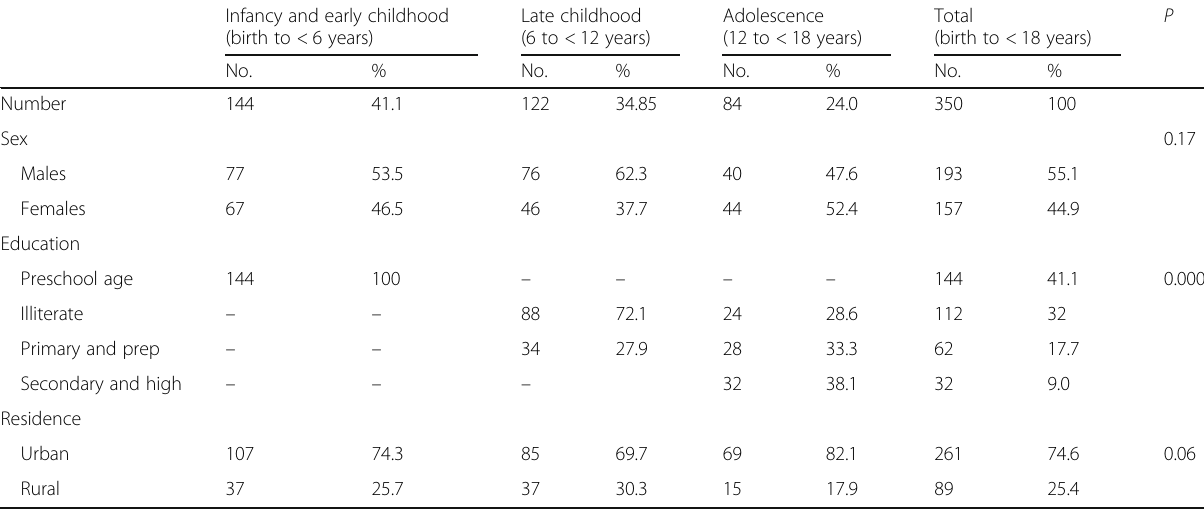
Table 2 Demographic data of patients with